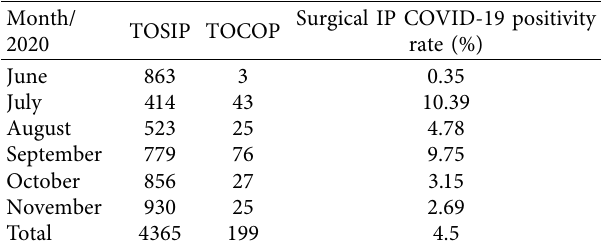
Table 5: COVID-19 positivity rate among the surgical